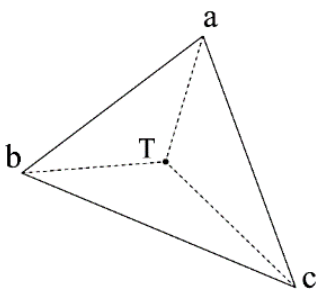
Figure 1. Triangulated Irregular Network (TIN) interpolation. a , b , and c have known elevation values. The elevation of T is to be